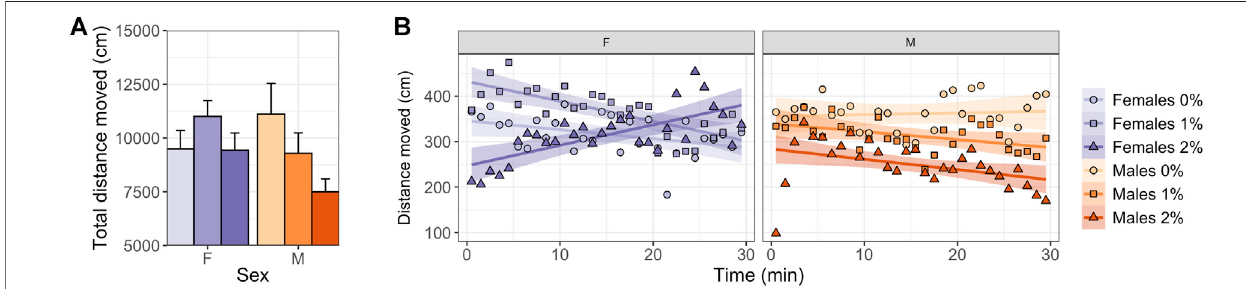
FIGURE2| LocomotoryactivityinthezMCSFofmaleandfemaleABzebra fi shacutelyexposedto0,1or2%(v/v)ethanolfor30 min. (A) Totaldistancemovedover the 30-min trial (in cm; mean ± SEM per group) and (B) distance moved per minute (in cm; mean per group) by female (F; purple colors) and male (M; orange colors)